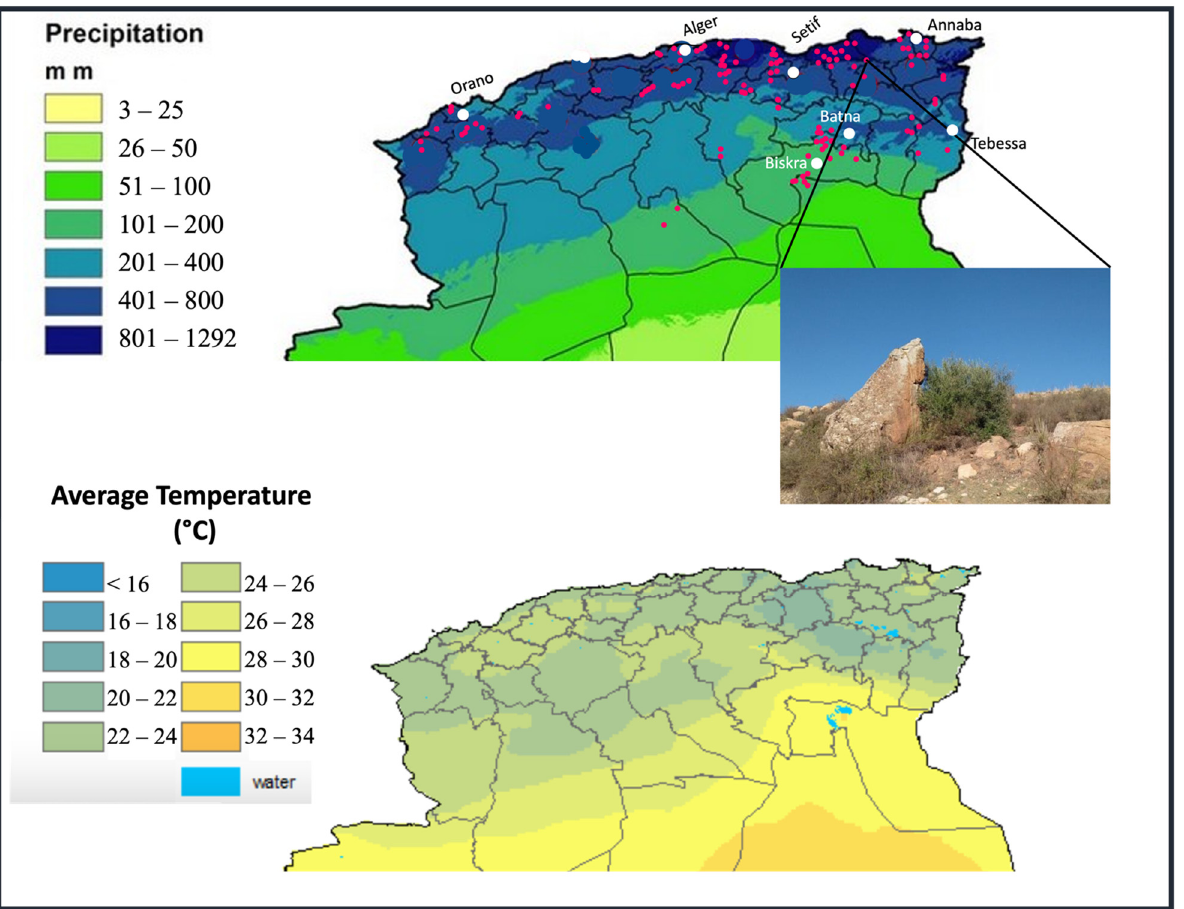
Figure 1. Map of Northern Algeria showing the sampling sites of wild trees. The average precipitation and temperature are also shown. The picture refers to the sample Constantine_11— Constantine, Djbel El Ouehch. Source: https://earlywarning.usgs.gov (accessed on 4 May 2022).